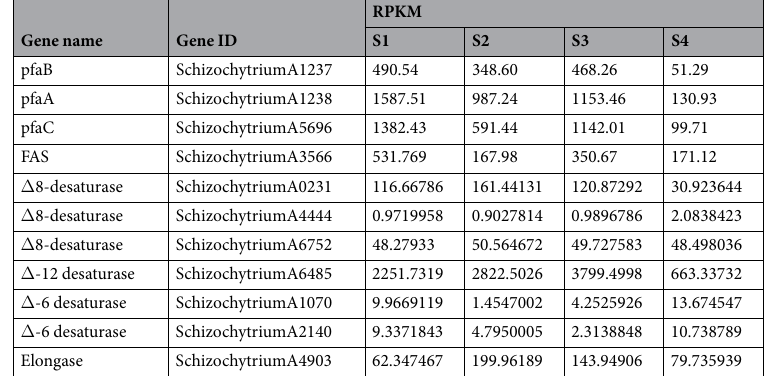
Table 2. Differential expression of key genes related to fatty acid